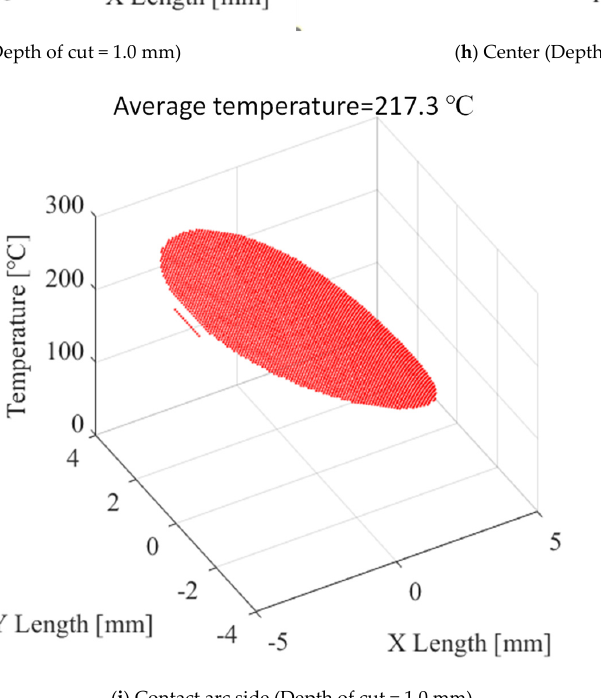
Figure 15. Two-dimensional temperature distribution at each temperature measurement position. At a depth of cut of 0.02 mm, the tendency for the lowest temperature to be at the measurement position on the contact arc side was the same in both the experimental and numerical analysis results. In the experimental results, the average temperature at the measurement position on the contact arc side was 30.5 ◦ C, which was 20 ◦ C or lower than the other positions. This was because the contact arc length was 1.30 mm at a depth of cut of 0.02 mm, which is small with respect to the measurement target area diameter ( φ 8). Since the surface of the workpiece before machining occupied most of the measurement target area, the average peak temperature was lowest then. When the depth of cut was 0.2 mm, the tendency for the highest temperature to occur at the center measurement position was the same in both the experimental and numerical analysis results. This was because the temperature measurement position included the point where the temperature peaked and not that of the workpiece surface before machining at room temperature. Finally, at a